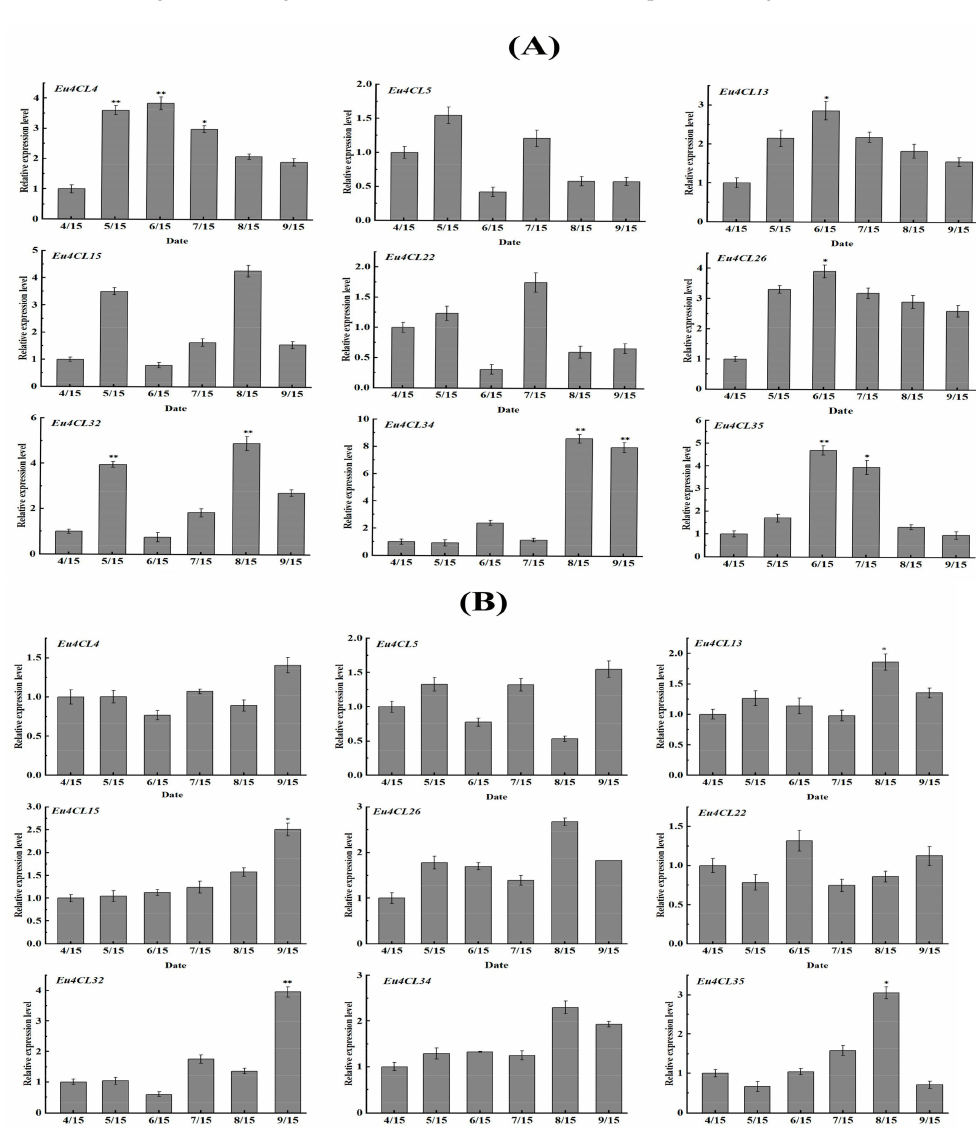
Figure 10. Expression profiles of selected Eu4CL genes in different developmental stages. ( A ) represents the expression of 4CL gene in leaves at different developmental stages. ( B ) represents the expression of 4CL genes in bark at different developmental stages. * means significant correlation at a level of 0.05. ** means significant correlation at a level of